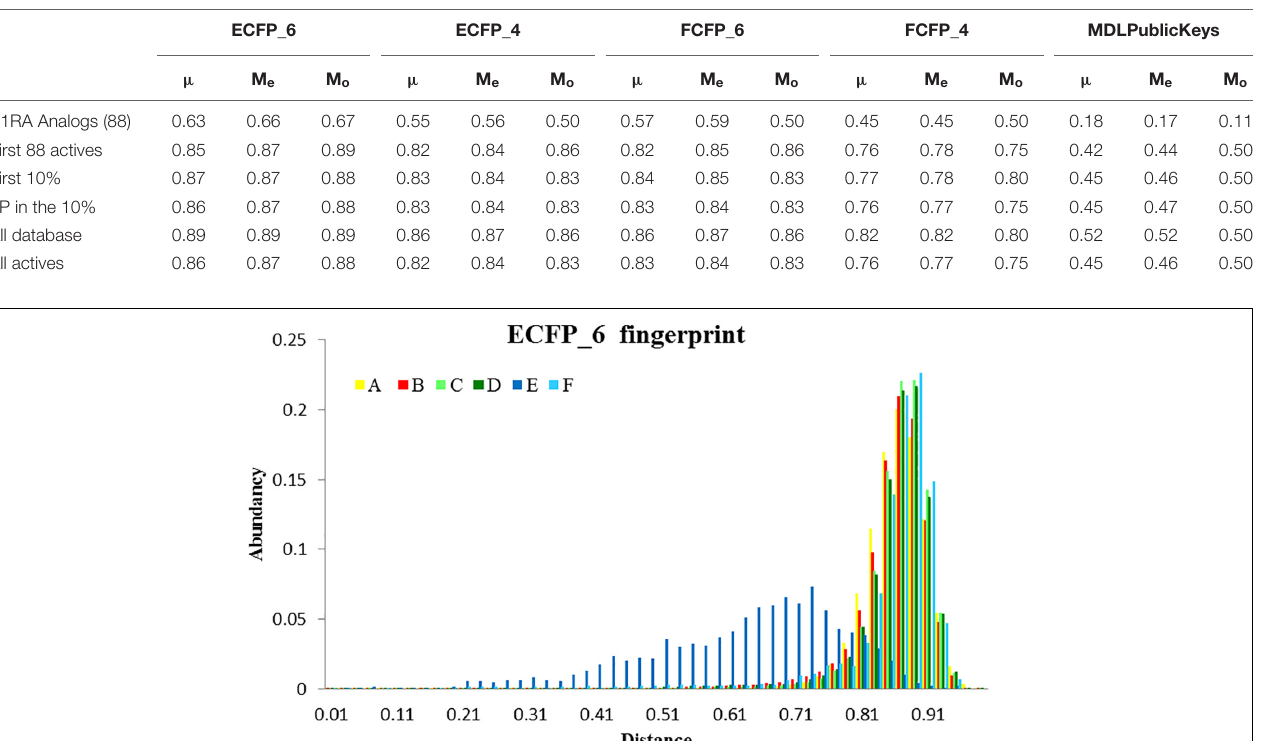
TABLE 4 | Average ( µ ), median (Me), and mode (Mo) pairwise Tanimoto distance values for five different subgroups: 88 analogs of the lead compound S1RA (E52862); the first 10% of selected compounds by the 5HK1–Ph.B model; the true active compounds within this 10%; all database compounds; all active compounds in the database.